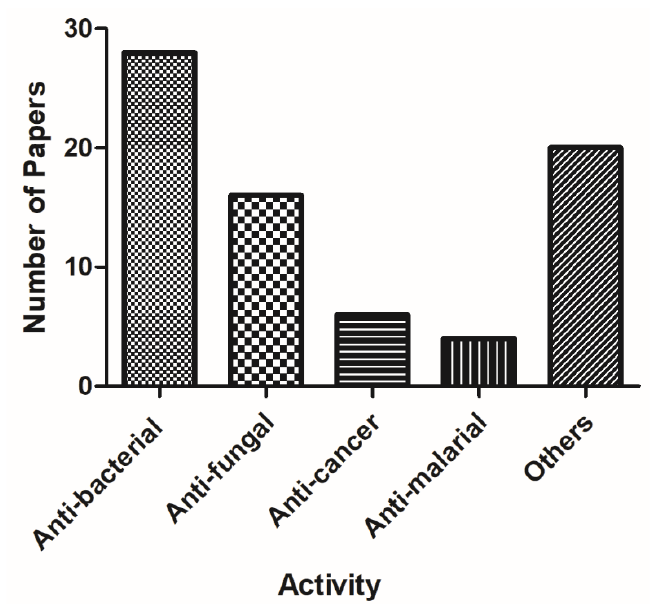
Figure 6. Number of papers reporting various activities of bacterial alkylquinolones .